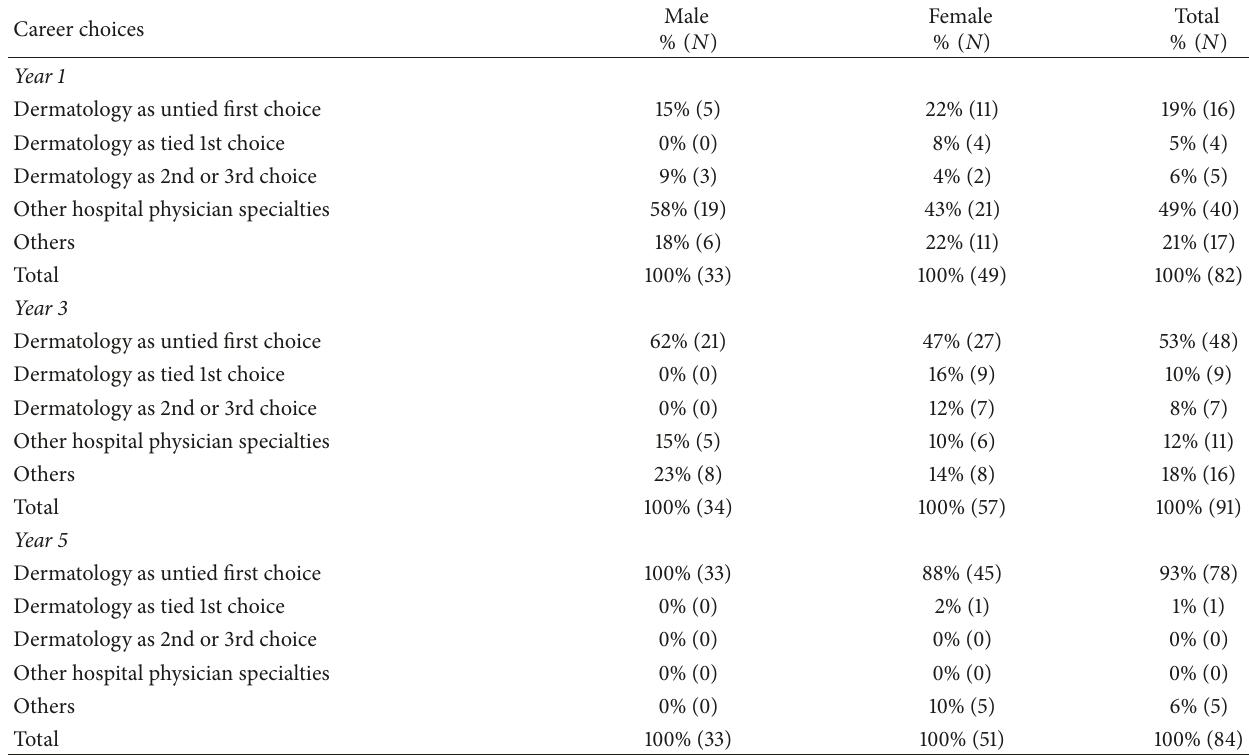
Table 6: Numbers and percentages of practicing dermatologists in year 10, based on their original any first career choices in years 1, 3, and 5 (looking